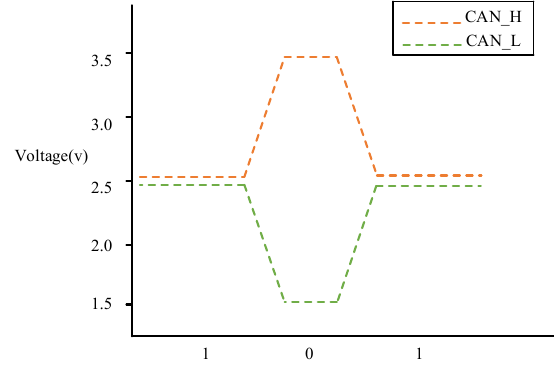
Figure 1. Signal logic of CAN bus.